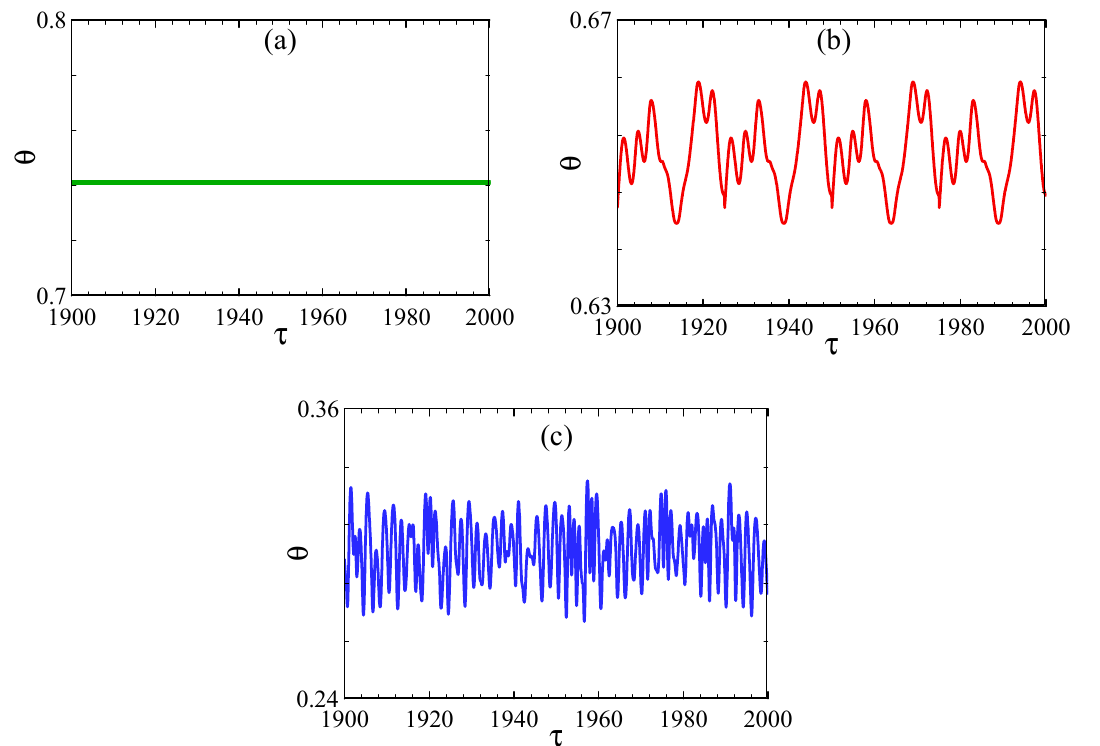
Figure 9. At the fully developed stage, temperature timeseries at point P 3 (0, 0.8) for ( a ) Ra = 10 6 , ( b ) Ra = 10 7 , and ( c ) Ra = 10 8 .